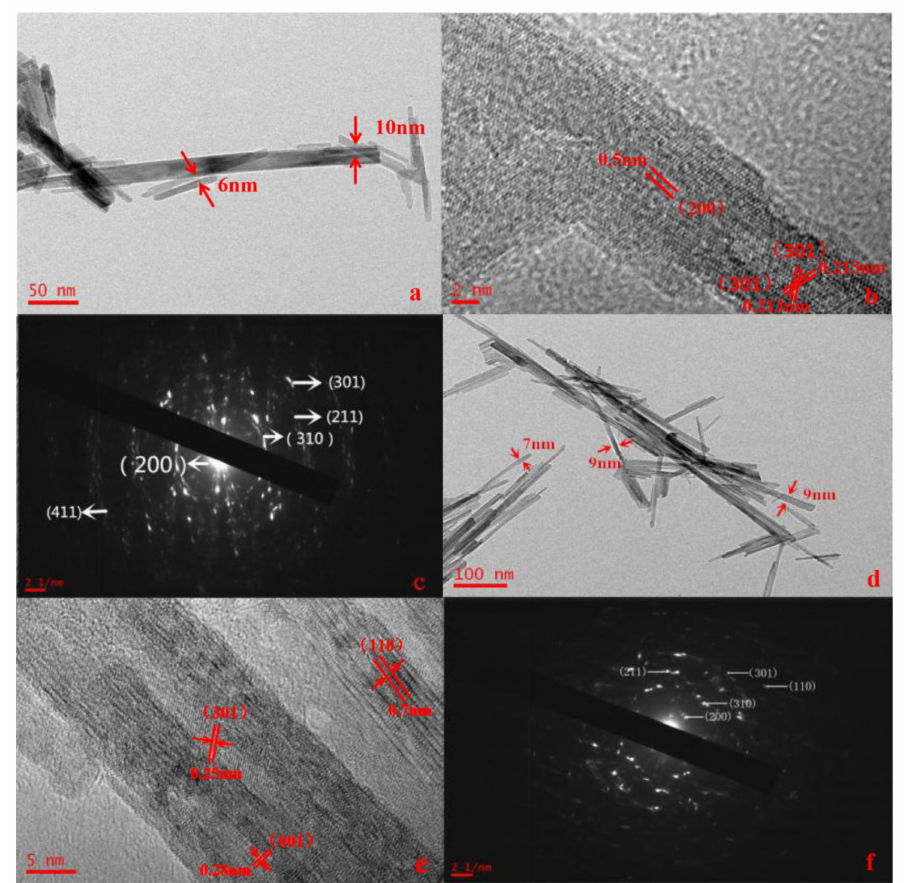
Figure 6. TEM of Co 0.2 -OMS-2 (( a ) TEM, ( b ) HRTEM, ( c ) SAED) and Co 0.4 -OMS-2 (( d ) TEM, ( e ) HRTEM ( f ) SAED).